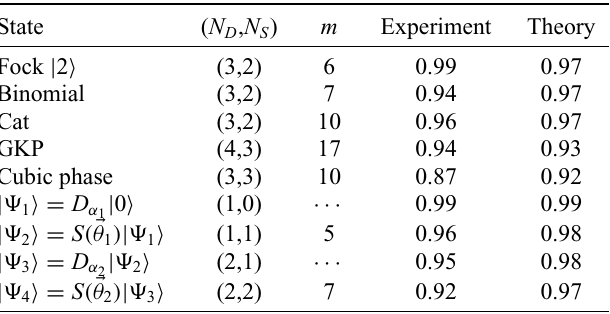
TABLE I. State fidelities for the generated states shown in Figs. 2 and 3. Here N D ( N S ) is the number of displacement- (SNAP) gates we use. The variable m is the highest Fock state that the SNAP gate applies a nonzero phase to. The | (cid:8) i (cid:4) are the states captured after each gate in a sequence of preparing the binomial